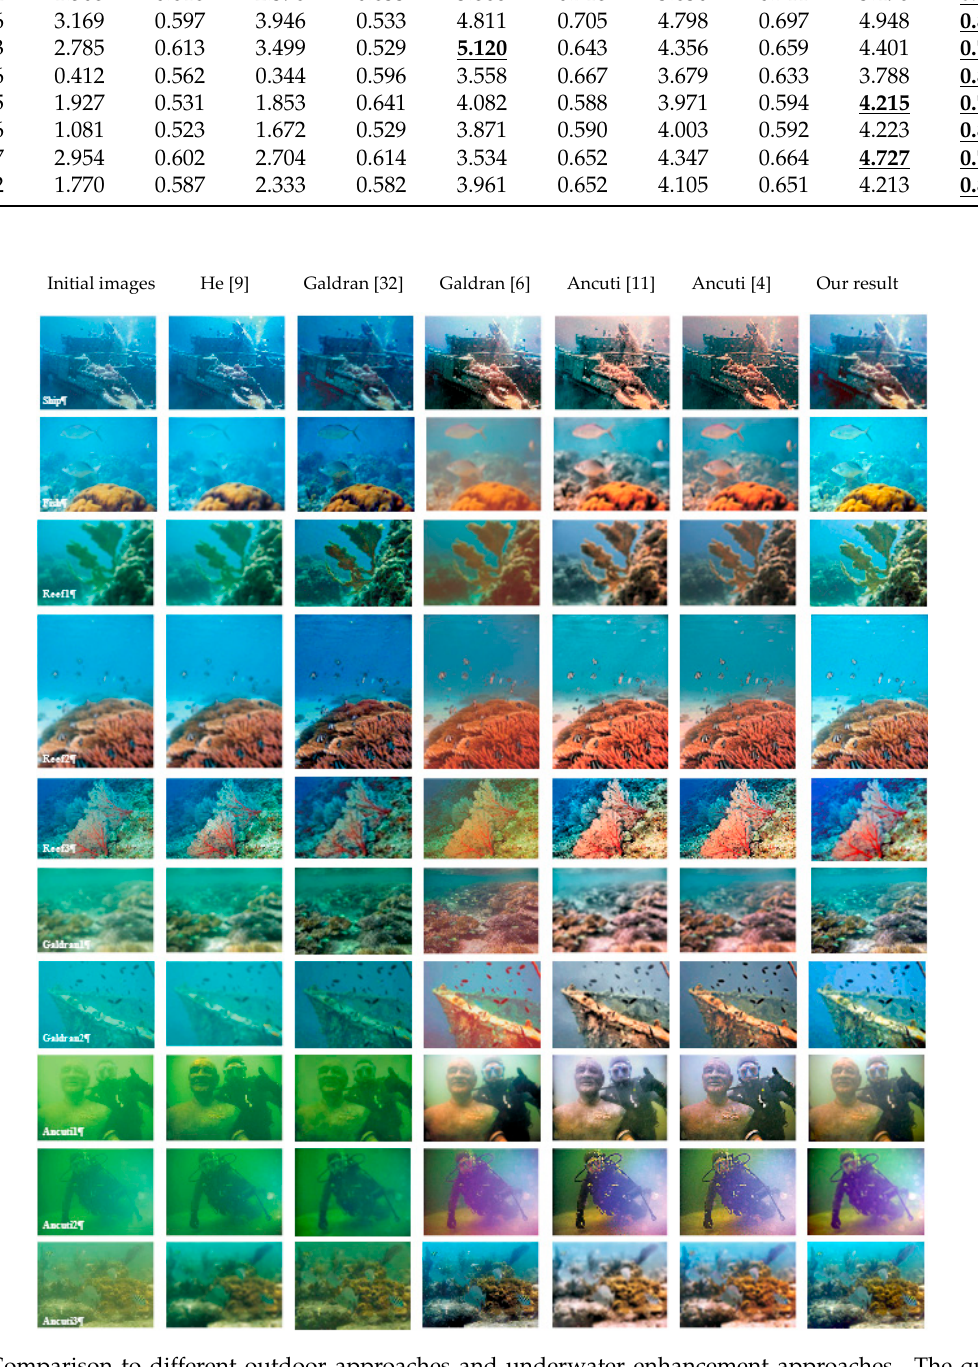
Figure 7. Comparison to different outdoor approaches and underwater enhancement approaches. The quantitative evaluation associated with these images is provided in Table 2.